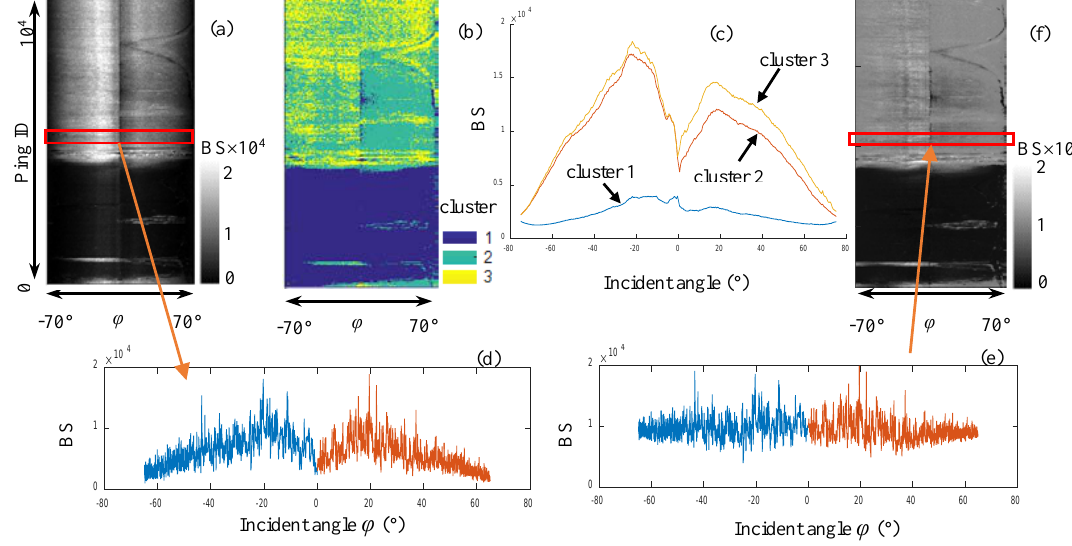
Figure 10. Radiometric correction with the proposed method: ( a ) raw SSS waterfall image; ( b ) corresponding classification image for k = 3; ( c ) three angle–BS curves of the three sediment clusters; ( d , e ) BS sequences of a ping before and after radiometric correction, respectively; and ( f ) new image after radiometric correction.